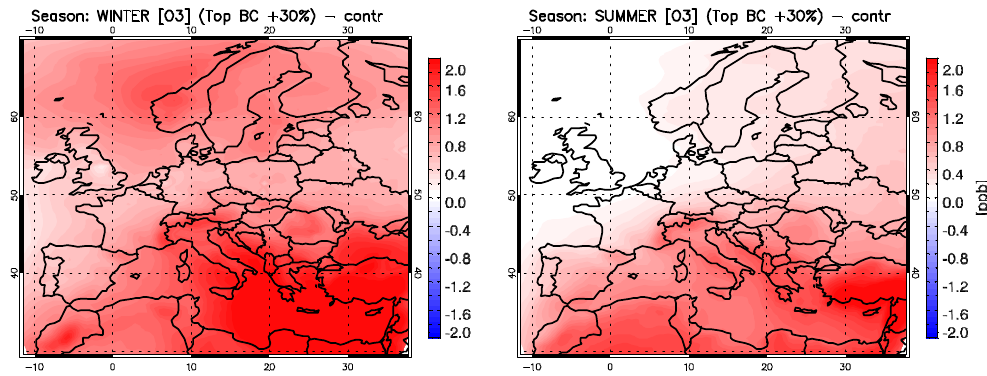
Fig. 10. Sensitivity study with 30% O 3 increase in the top boundary conditions. The plots show changes in seasonal average surface ozone concentrations for the winter (left) and the summer (right) season.